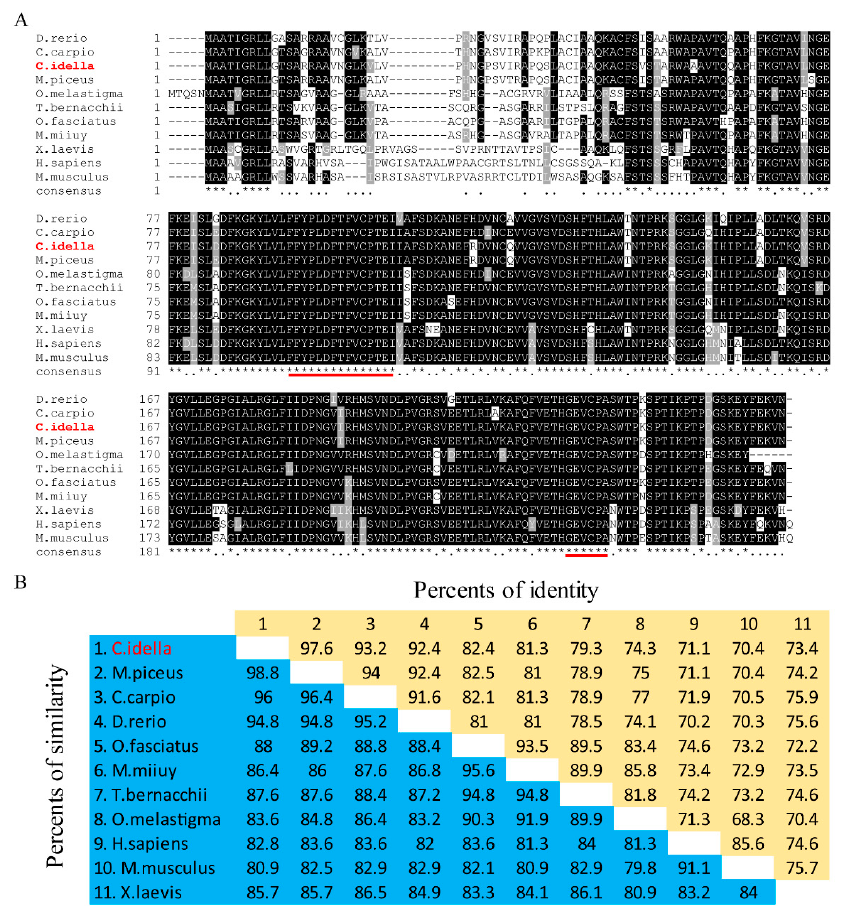
Figure 1. Multiple sequence alignment of CiPrx3 with its homologues from other species. ( A ) Multiple sequence analysis of CiPrx3 by ClustalW. The numbers of amino acids are listed on the left side of alignments. The black shade represents 100% identity, while dark gray represents 80% identity. Prxs signature motifs FYPLDFTFVCPTEI and GEVCPA are marked with red lines. ( B ) Identity and similarity of CiPrx3 with its counterparts from other species. The percent identity is shown in the upper triangle, and the percent similarity is shown in the lower triangle. GenBank accession numbers for the protein sequences are as follows. Mylopharyngodon piceus Prx3 (ALD62539.1); Trematomus bernacchii Prx3 (APG79659.1); Oplegnathus fasciatus Prx3 (AJC98155.1); Miichthys miiuy Prx3 (AGT56738.1); Cyprinus carpio Prx3 (ALG02339.1); Homo sapiens Prx3 (AAH08435.1); Mus musculus Prx3 (EDL01849.1); Danio rerio Prx3 (AAH92846.1); Oryzias melastigma Prx3 (AEA51070.1); Xenopus laevis Prx3 (NP